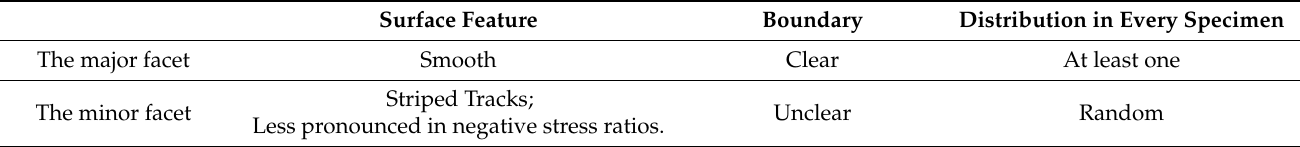
Table 3. Characteristics of the major and minor